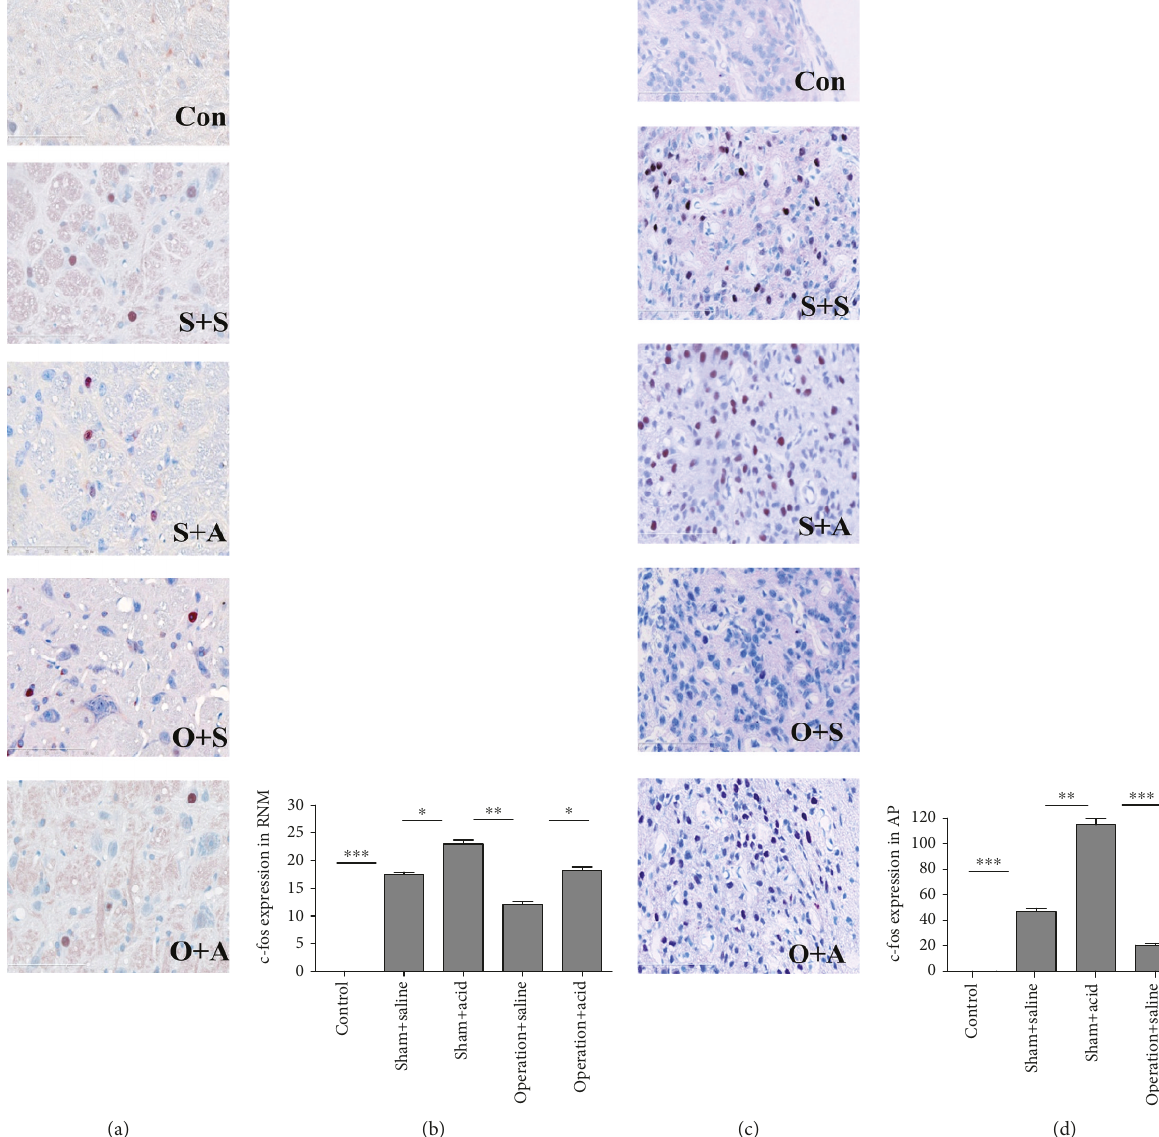
Figure 6: DMV destruction attenuated c-fos expression in the RNM and AP. (a) c-fos-positive cells with red nuclei in the RNM in the di ff erent groups ( × 400). (b) Induction of c-fos expression in the RNM by esophageal instillation and DMV destruction. c-fos expression in the RNM increased more in the sham + acid group than in the sham + saline group ( P < 0 05 ). After DMV destruction, c-fos expression decreased more signi fi cantly in the RNM in the operation + saline group than in the sham + acid group ( P < 0 01 ). c-fos expression was higher in the RNM in the operation + acid group than in the operation + saline group ( P < 0 05 ). (c) c-fos-positive cells with red nuclei in the AP in all groups ( × 400). (d) The e ff ects on c-fos expression in the AP of esophageal instillation and DMV destruction. c-fos expression in the AP increased more signi fi cantly in the sham + acid group than in the sham + saline group ( P < 0 01 ). After DMV destruction, c-fos expression more signi fi cantly decreased in the AP in the operation + saline group than in the sham + acid group ( P < 0 001 ). c-fos expression was much higher in the AP in the operation + acid group than in the operation + saline group ( P < 0 01 ) (Con: control group; S+S: sham + saline group; S+A: sham + acid group; O+S: operation + saline group; O+A: operation + acid group. n = 8 , ∗ P < 0 05 , ∗∗ P < 0 01 , and ∗∗∗ P < 0 001